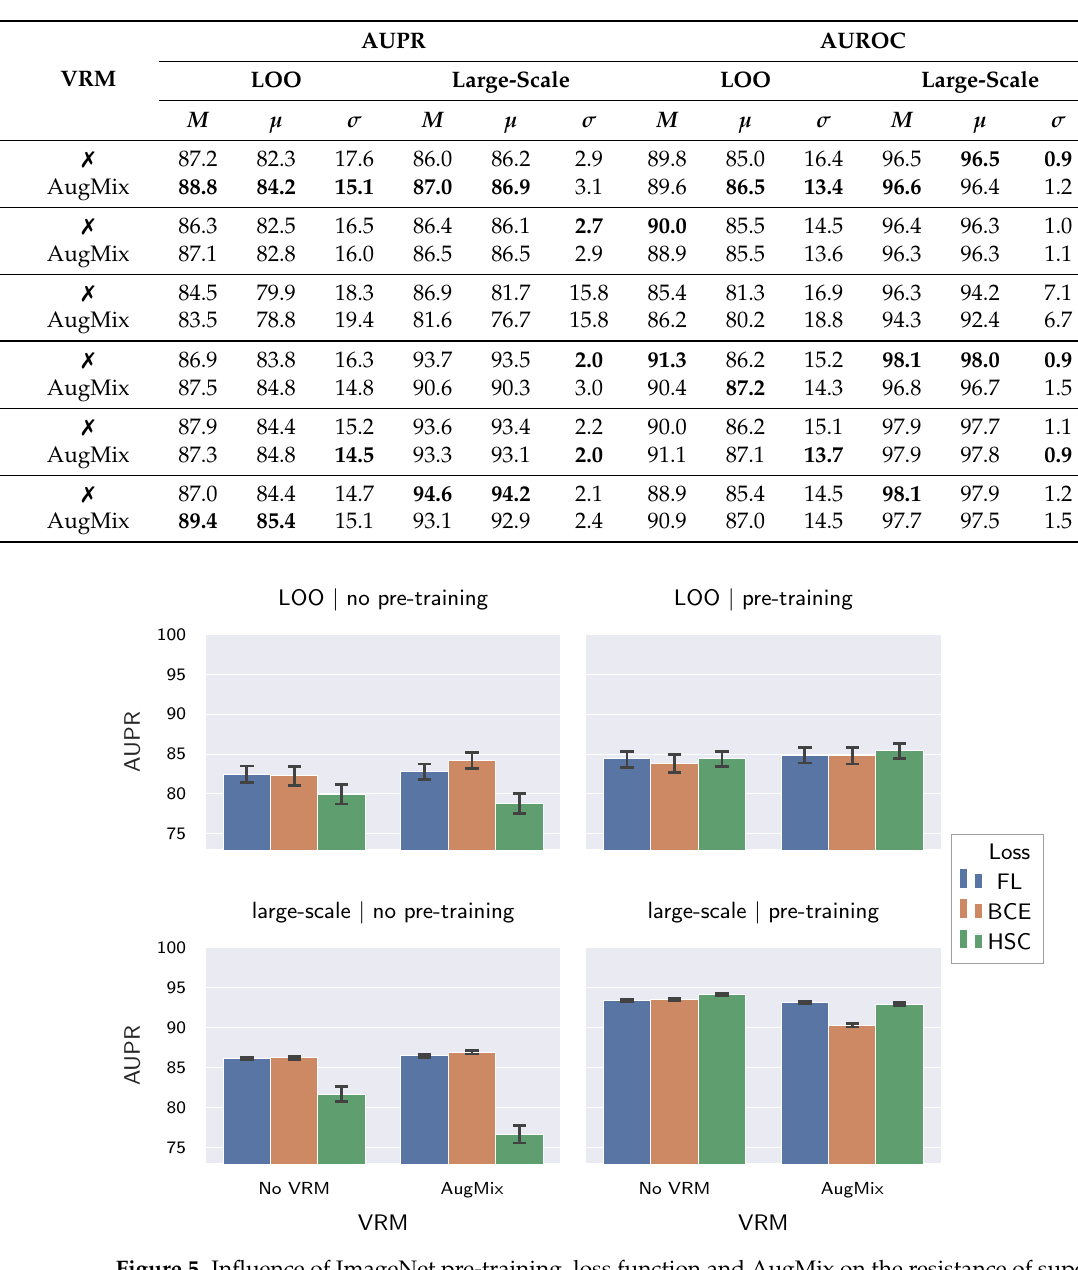
Table 5. Influence of ImageNet pre-training, loss function and AugMix on the resistance of supervised fabric AD methods to distribution shifts. Best scores for transfer learning and training from scratch are highlighted in bold.